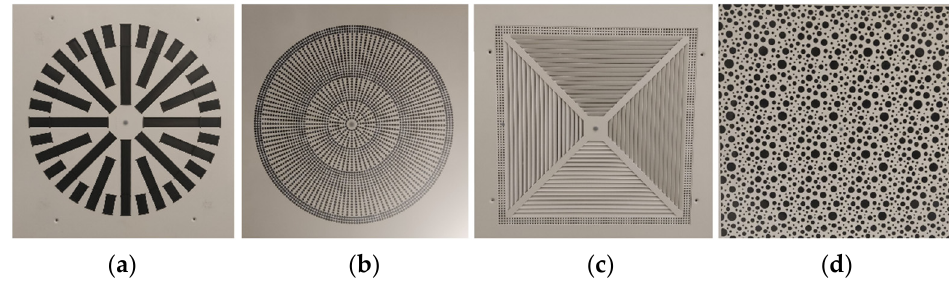
Figure 4. Examined diffusers: ( a ) DQJA SR, ( b ) Pil-R-Z, ( c ) 4-DF, ( d ) Xarto-Q6.